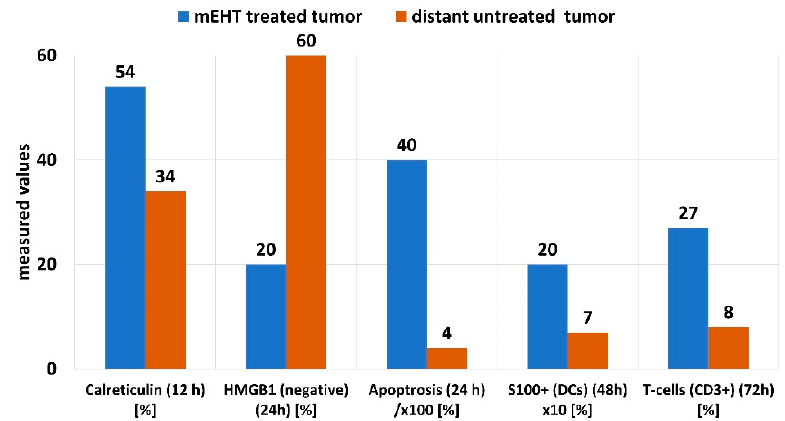
Figure 16. DAMP-related activity in C26 allografts following treatment with mEHT.